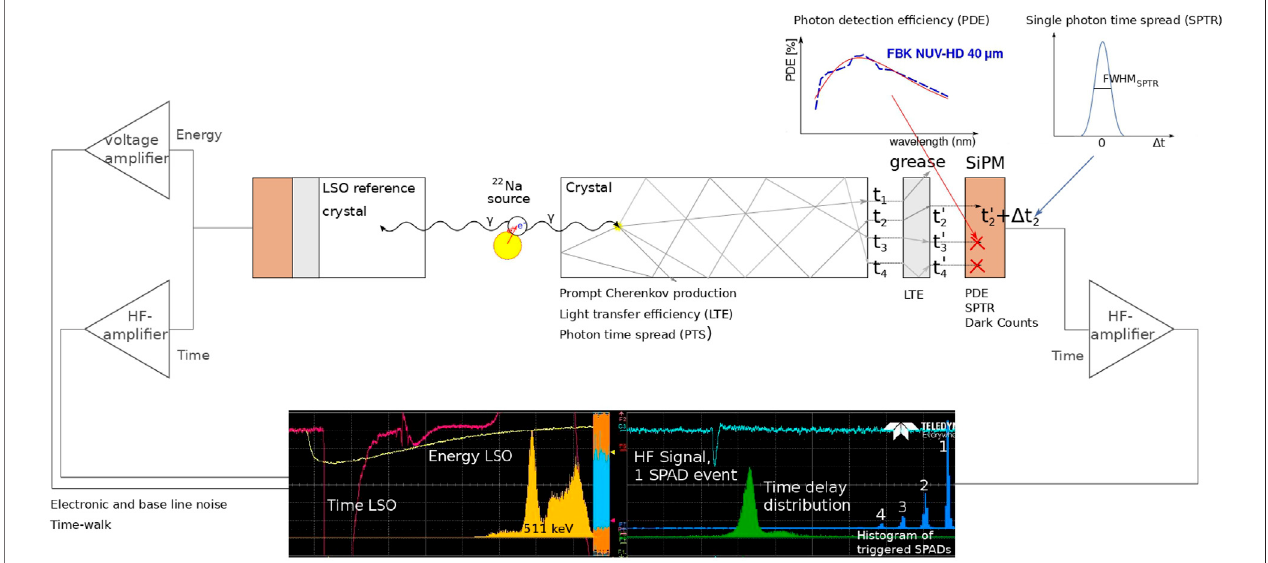
FIGURE 2 | Schematic drawing ofthe coincidence time resolution setup used to perform the coincidence measurements and reproduced via Geant4 simulations.